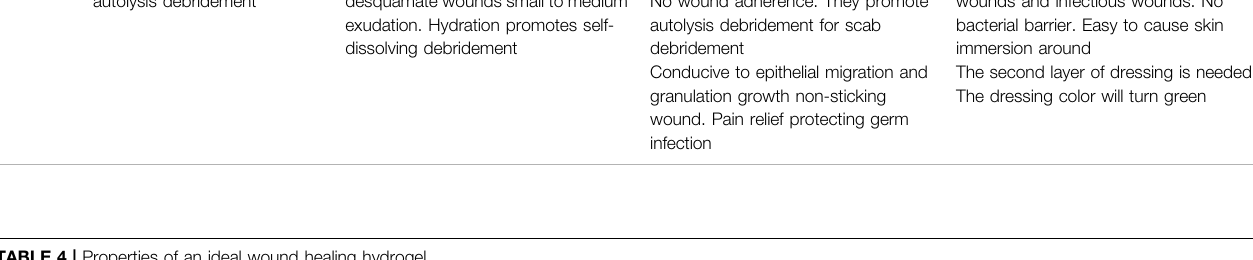
TABLE 4 | Properties of an ideal wound healing